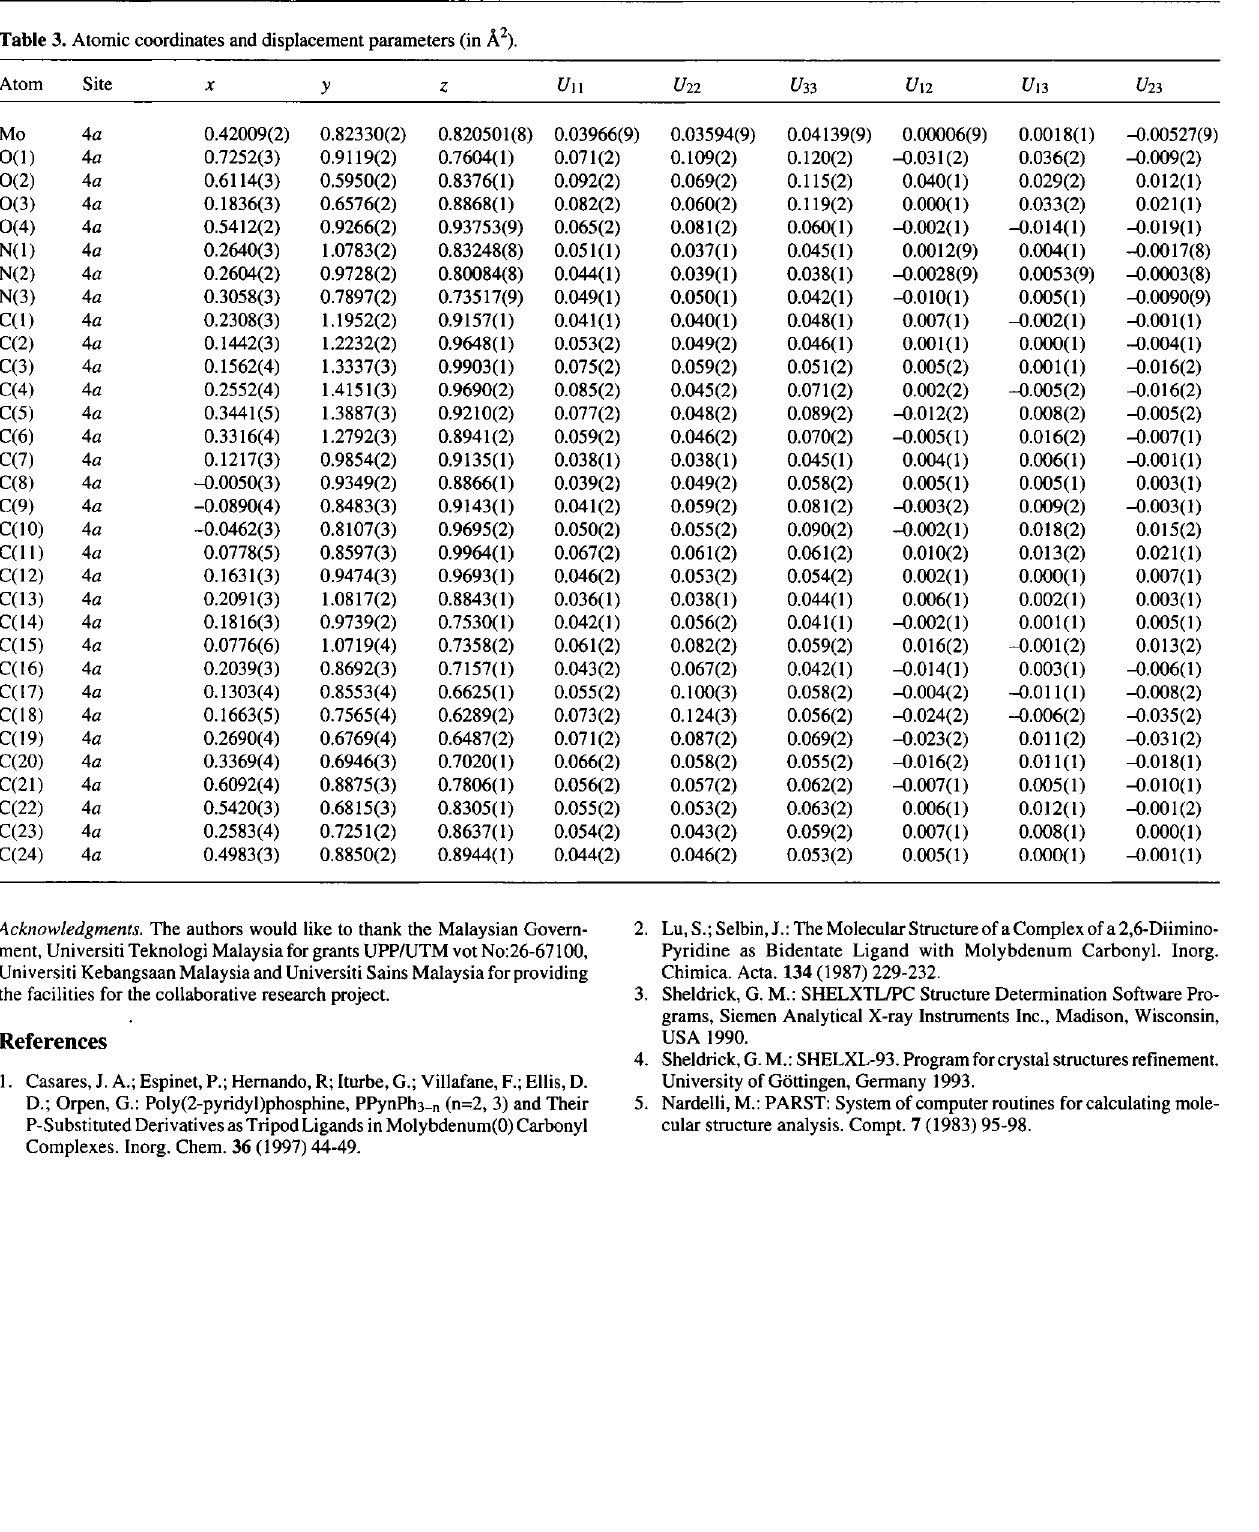
Table 3. Atomic coordinates and displacement parameters (in A 2